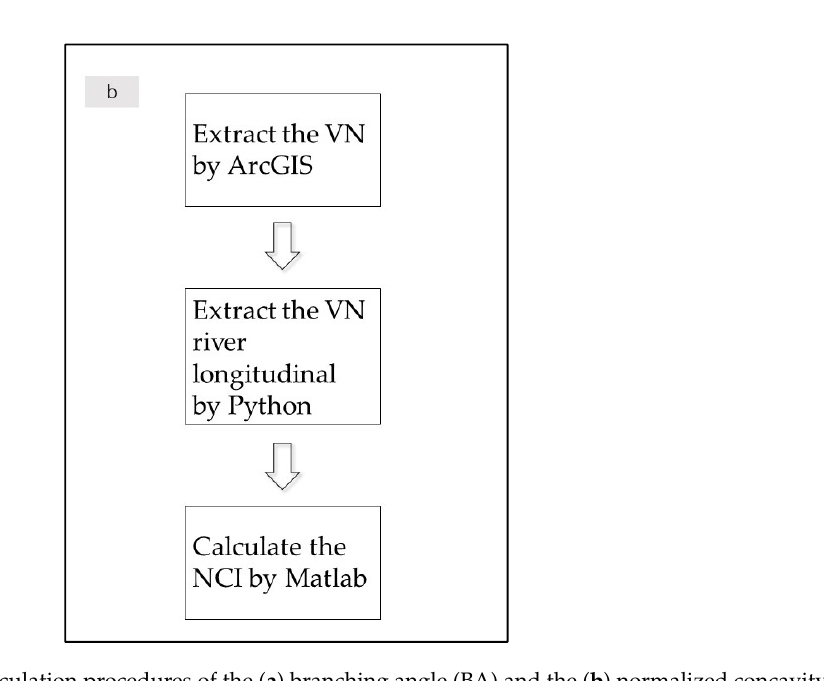
Figure 2. The diagram of the calculation procedures of the ( a ) branching angle (BA) and the ( b ) normalized concavity index (NCI) of the longitudinal profiles of the rivers. VN: valley network. BA: branching angle.